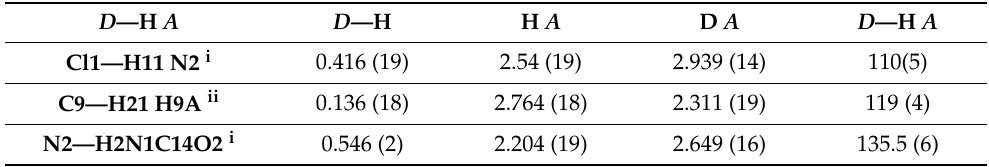
Table 3. The H-bond geometry of compound 4 (Å, ◦